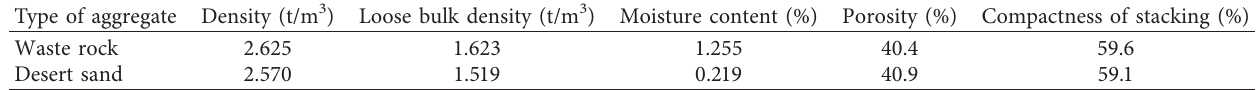
Table 3: Physical parameters of filling aggregate.